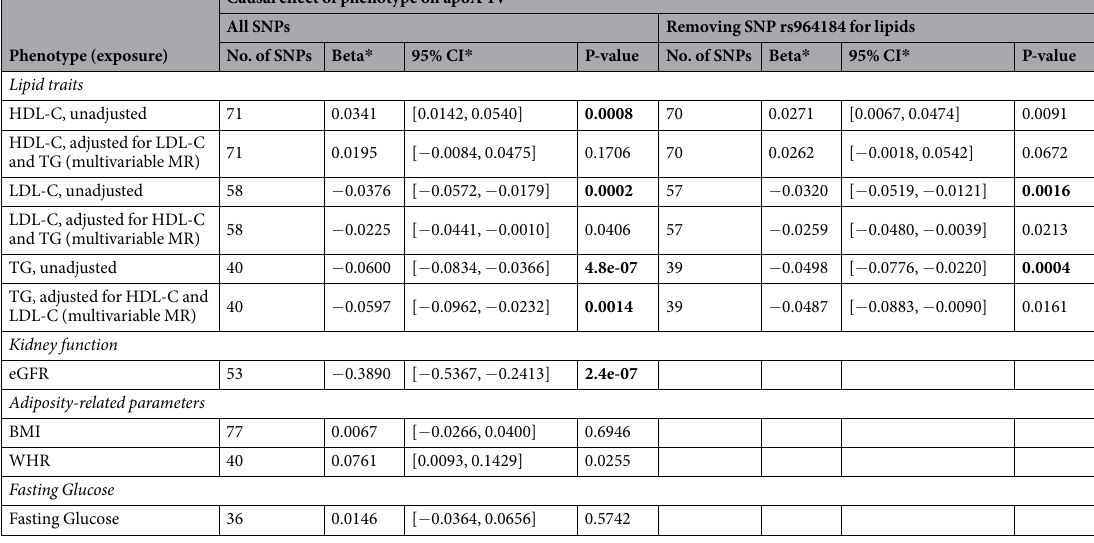
Table 3. MR-IVW estimates for all phenotypes assumed to causally affect the apoA-IV concentrations. Here, the phenotypes act as exposures and apoA-IV as the outcome. A p-value smaller than 0.05/8 = 0.00625 is considered to be significant (marked in bold). * In log(apoA-IV) per change in SD for the lipid and obesity traits, in log(apoA-IV) per change in log(eGFR) for kidney function, in log(apoA-IV) per change in mmol/L for fasting glucose.